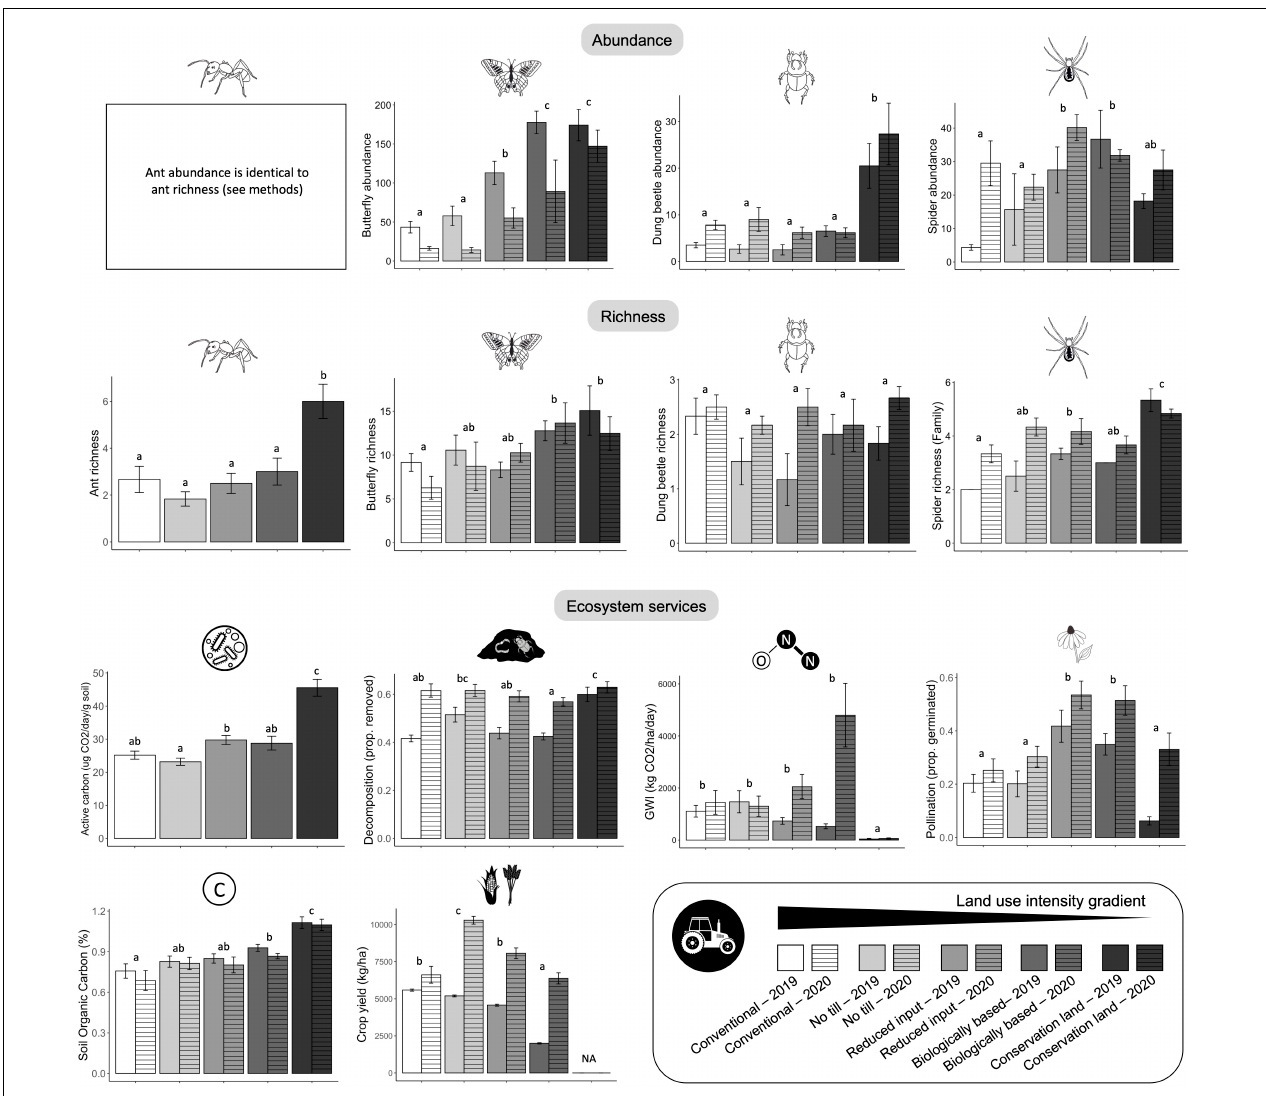
FIGURE 3 | Effects of crop management treatment on measures of biodiversity and ecosystem services between years 2019 and 2020. For measures of biodiversity, bars depict means over an entire year; for measures of ecosystem services, bars depict means for each sampling round. Letters denote statistical differences among treatments. Error bars show standard errors. Ants and active carbon were only measured in